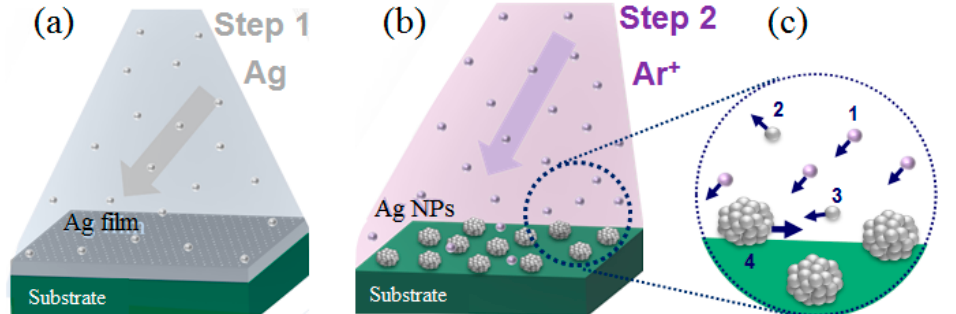
Figure 1. The schematic illustration of Ag NPs formation. ( a ) Magnetron deposition of the silver films. Film irradiation by low-energy low-dose Ar + ions ( b ) leading to the formation of the nanoparticles. Characteristic processes ( c ): 1—Ar + flux; 2—Ag sputtering; 3—Ag resputtering; 4—surface diffusion of the adatoms and adsorbed clusters enhanced by ion irradiation.